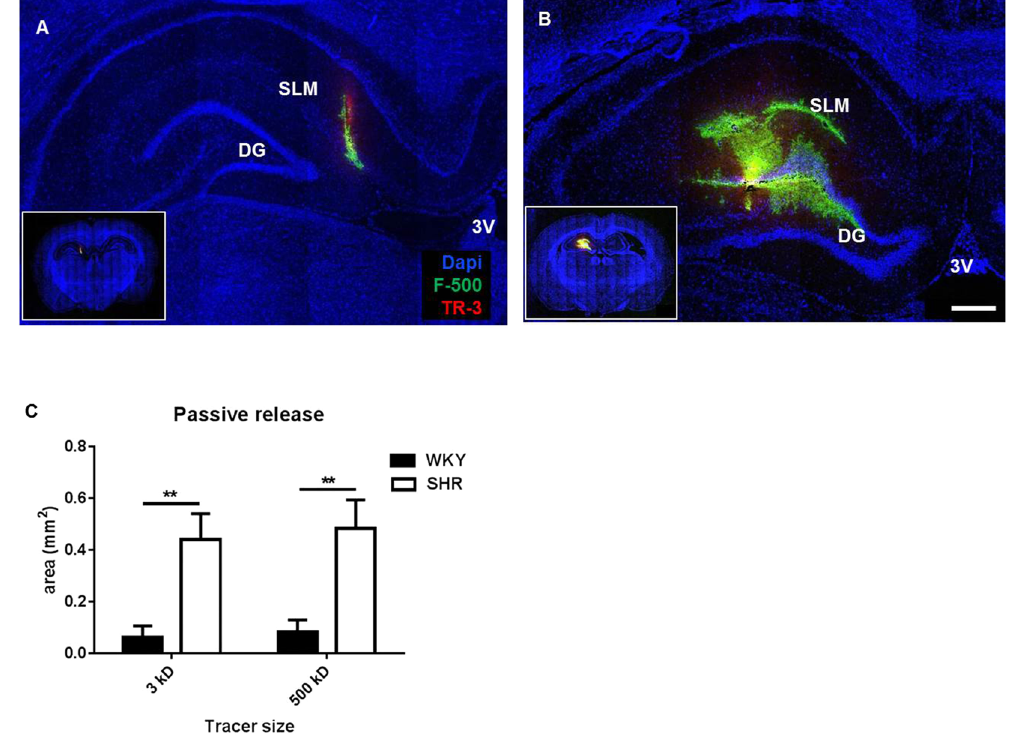
Figure 2. Distribution of tracers after passive release into the hippocampus. Panel A and B show representative coronal sections of WKY (left) and SHR (right) hippocampus at the level of needle insertion. Inserts show the overview of the whole sections. Panel C shows the quantification of the distribution area. Data are mean ± SEM. ** Indicates P ≤ 0.001. WKY = 8 SHR = 6. Scale bar 1 mm.